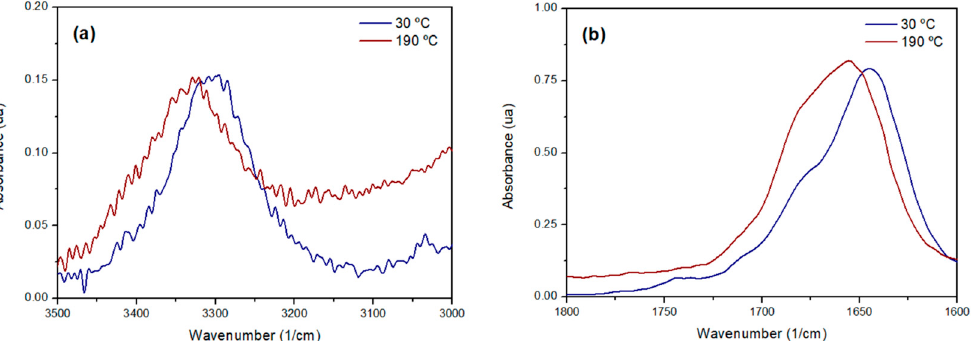
Figure 11. FTIR-ATR spectra of the sample SQLM 2575 BASE expanded in the regions of N-H ( a ) and C=O ( b ) vibrations at 30 and 190 °C temperatures.